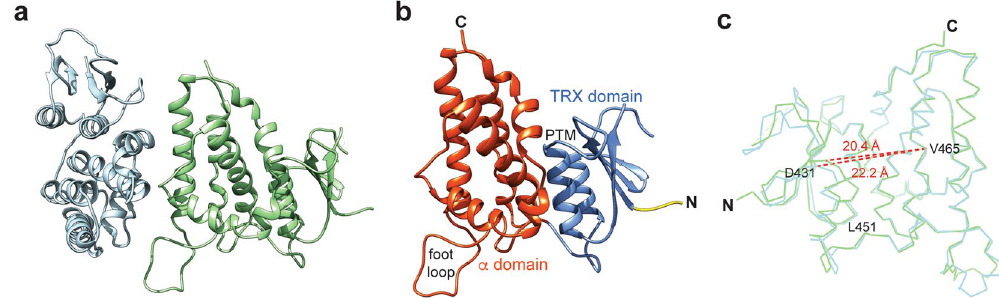
Figure 1. The structure of mCLIC6. ( a ) Cartoon representation of the asymmetric unit from the P 2 1 crystal form showing chain A and B in cyan and green, respectively. ( b ) Cartoon representation of chain B. The structural motifs of the CLIC domain are labeled. ( c ) Superposition of the chains A and B from the P 2 1 crystal form. Dashed red lines show distances between the indicated positions.